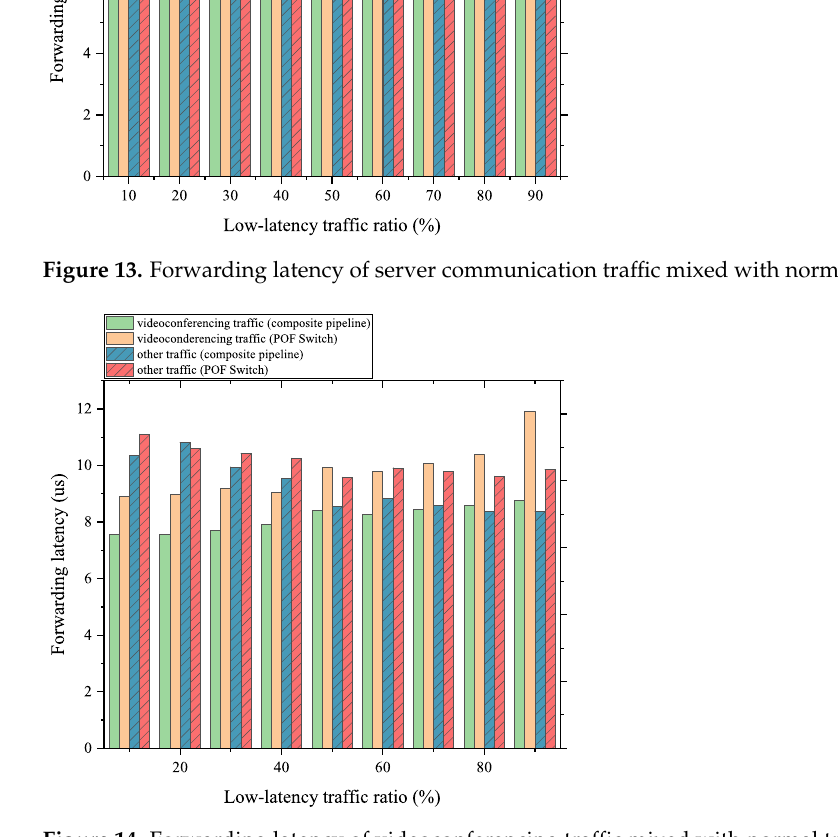
Figure 14. Forwarding latency of videoconferencing traffic mixed with normal traffic.